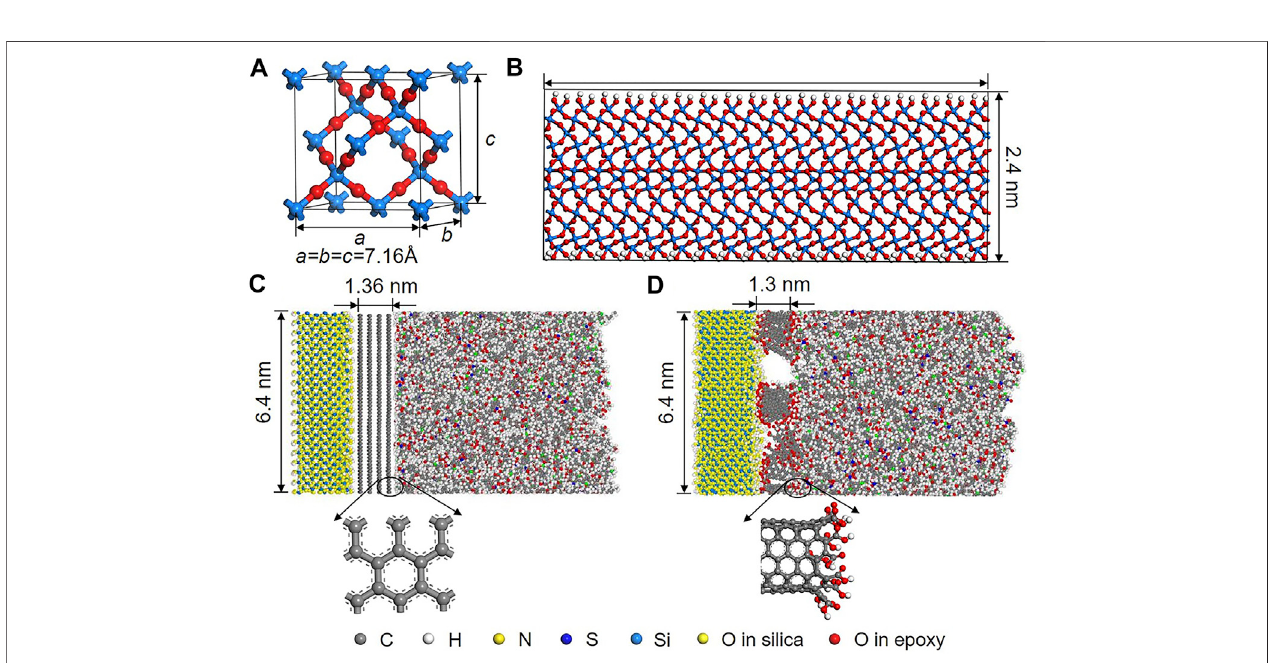
FIGURE 2 |(A) Lattice unit of β -cristobalite asthe initial structure of silica; (B) equilibrated silica structure with the surface covered by hydroxylgroups; equilibrated sandwiched systems coated by (C) graphene with four layers and (D) SWCNTs with a length of around 1.3 nm. The end of SWCNTs is saturated with carboxyl groups.